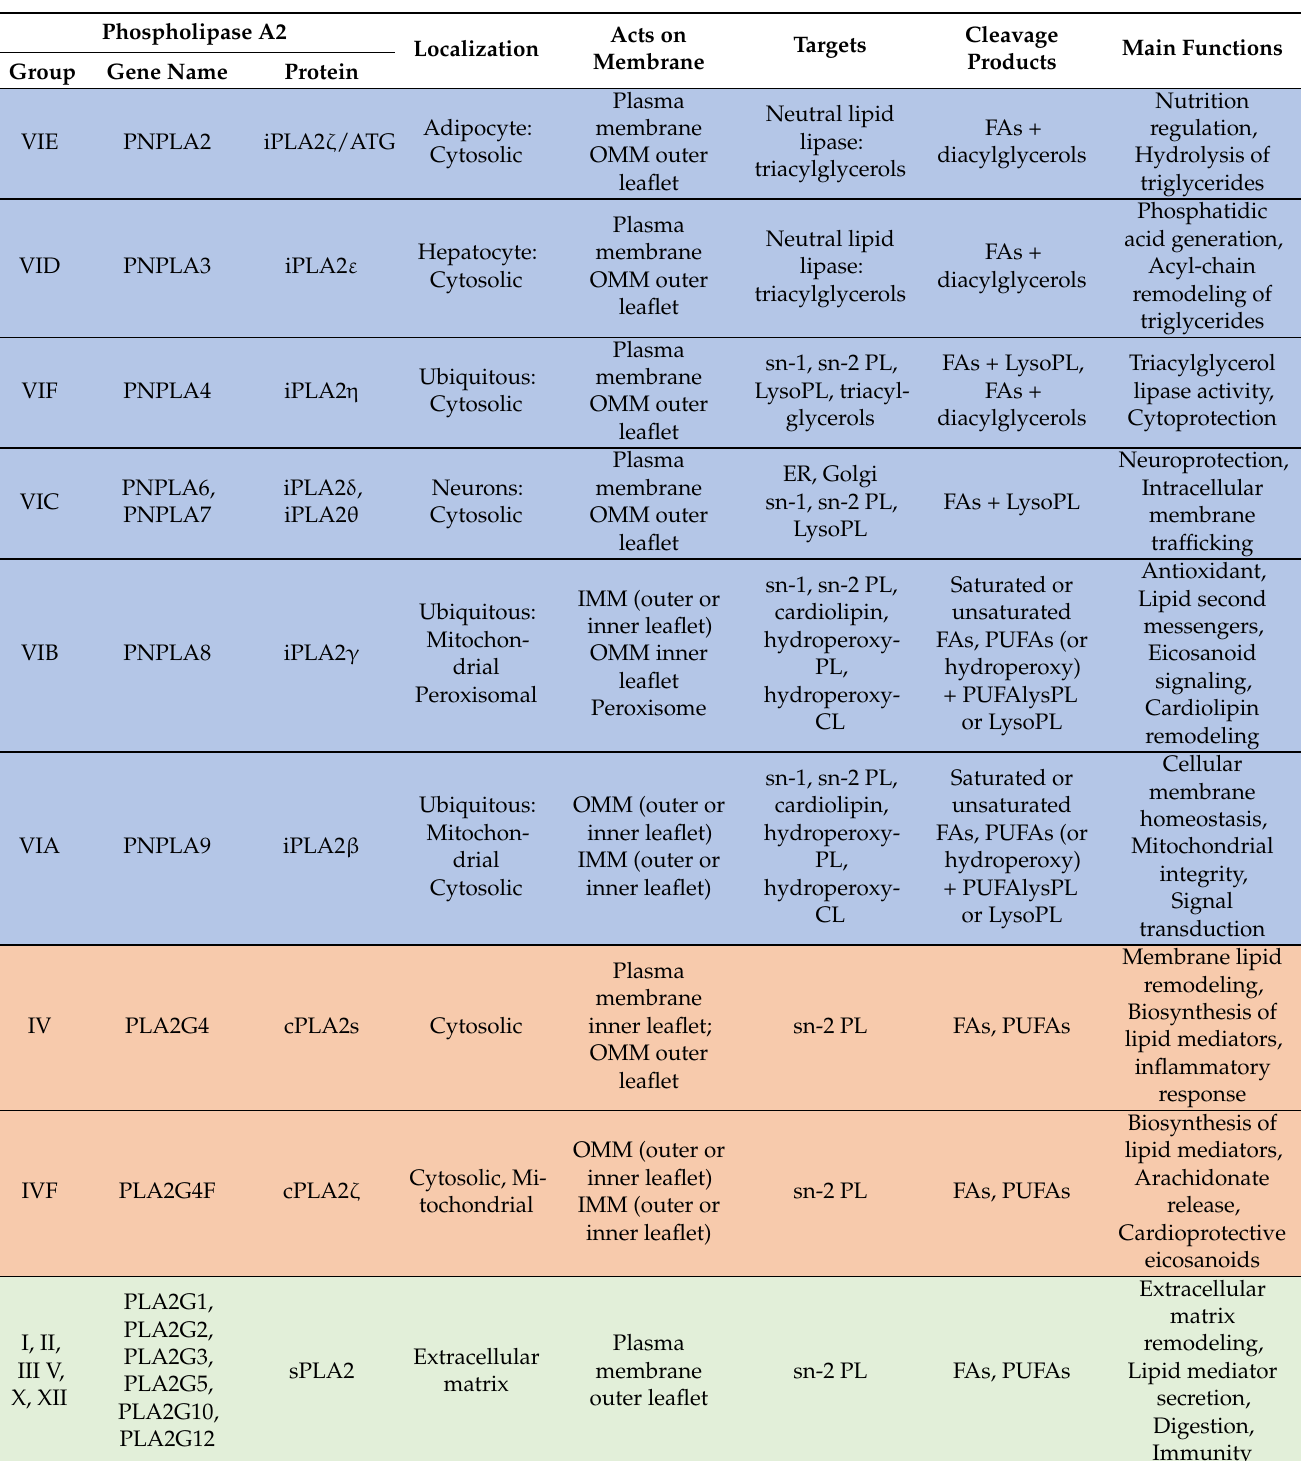
Table 1. Overview of selected intracellular calcium-independent phospholipases A2 (patatin-like phospholipase domain- containing proteins, PNPLA), calcium-dependent cytosolic phospholipases A2 (cPLA2s), and low-molecular-weight secreted phospholipases A2